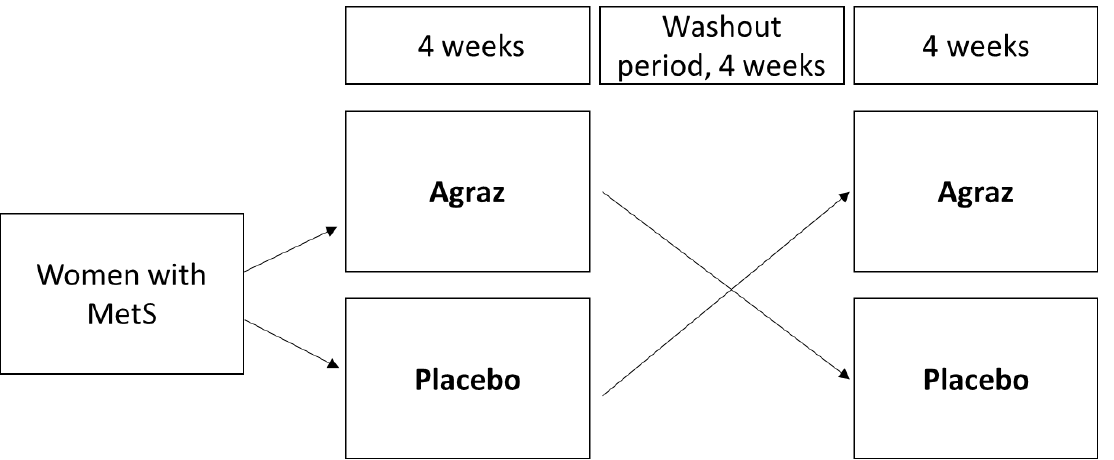
Figure 1. Study protocol. Women consumed agraz and placebo in a crossover design during 12